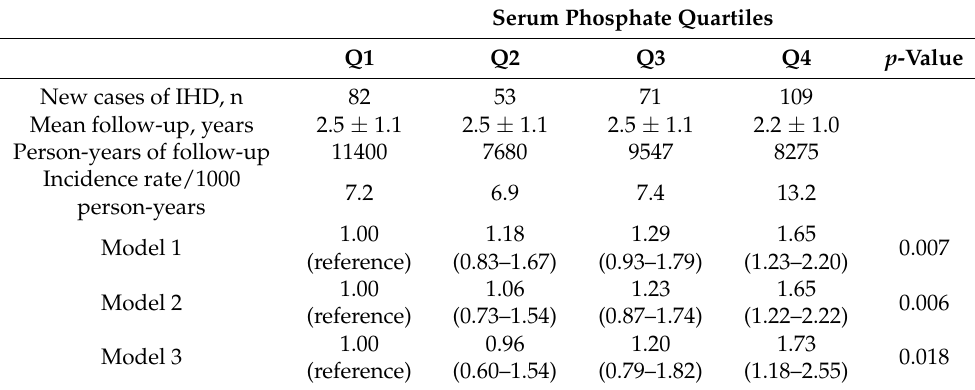
Table 4. Hazard ratios and 95% confidence intervals for new-onset ischemic heart disease (IHD) according to serum phosphate quartiles.